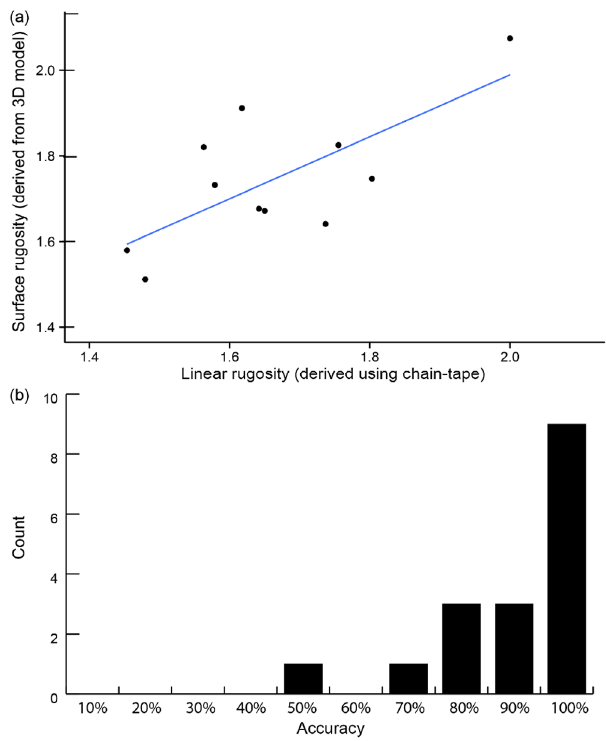
Figure 7. Heat-map of surface rugosity of a section of a 500 m of the reef transect. Both x and y -axes denote distance in metres, the transect width ranged from 4 to 30 m. Surface rugosity was calculated in 2 × 2 m quadrats. Structural complexity was calculated as in [30], where a value of 1 represents a flat quadrat and the index increases with habitat structural complexity.